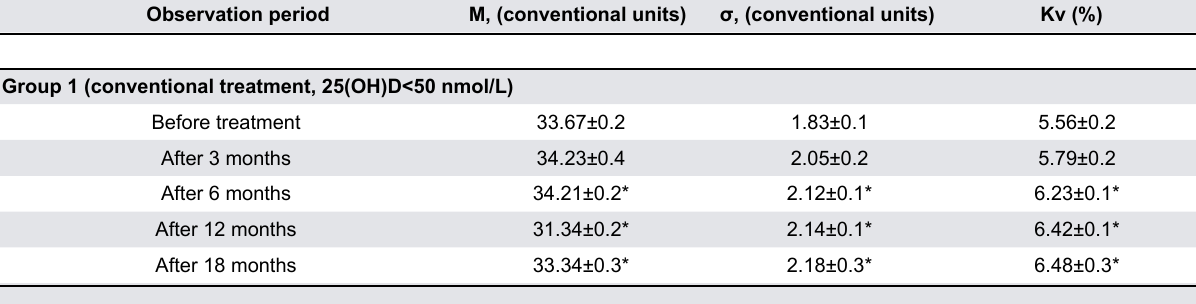
Table 6- The dynamics of microcirculation changes during the treatment